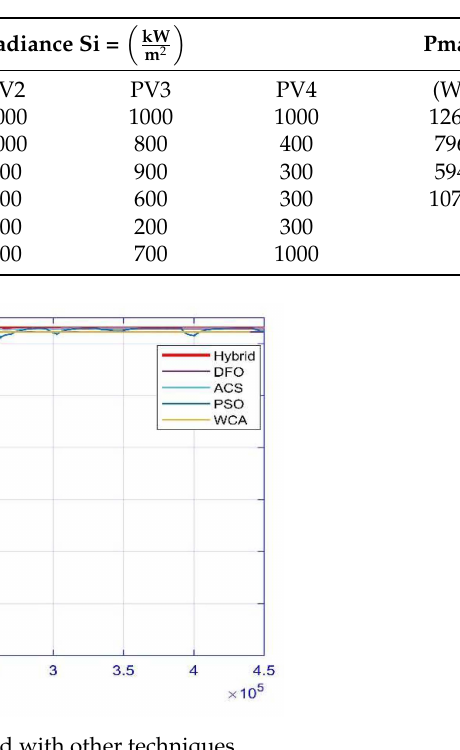
Figure 4. Case 1: Power Comparison of hybrid with other techniques. The red bold line in the graph represents our hybrid algorithm, while the blue line represents bio-inspired particle swarm optimization (PSO), the sky blue line represents adaptive cuckoo search optimization (ACS), the purple line represents the dragonfly